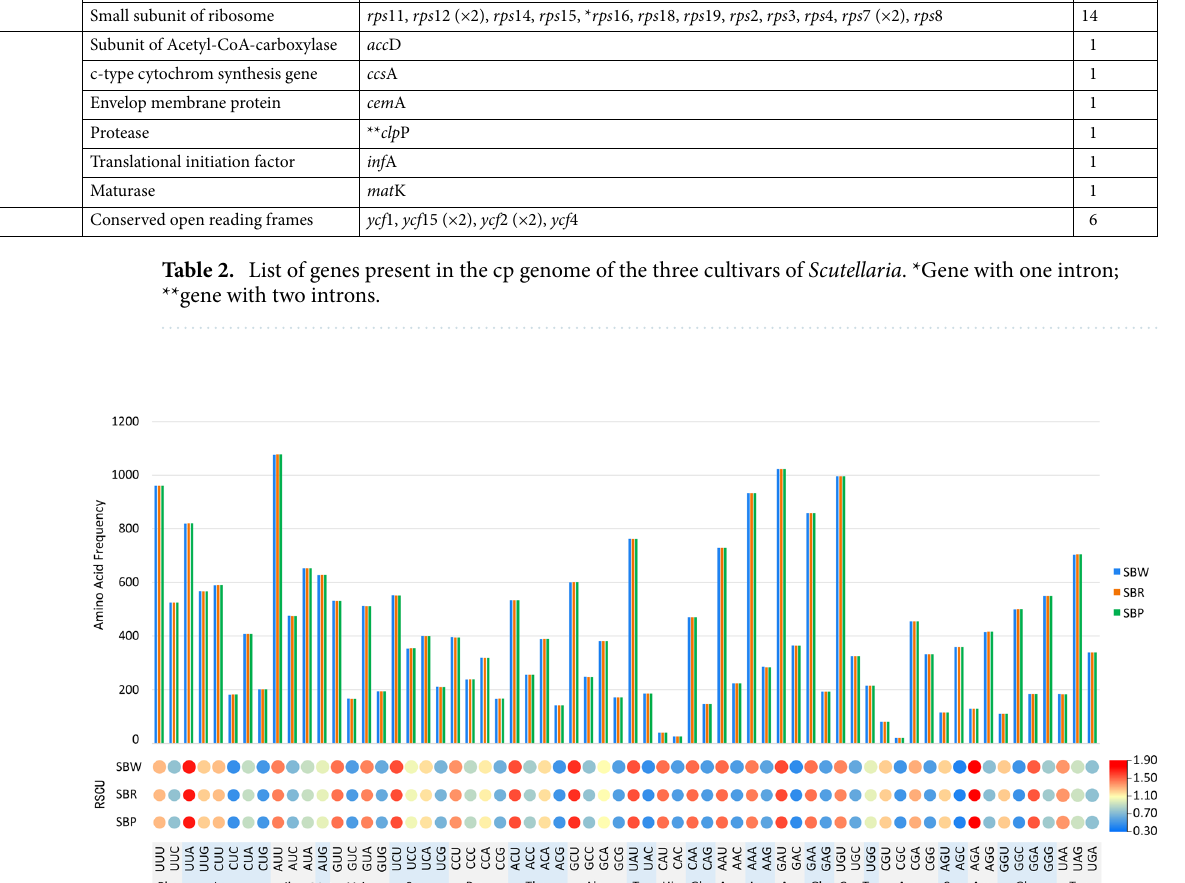
SSC region. In addition, the ycf 3 and clp P comprise two introns (Table S1). According to the statistics of intron